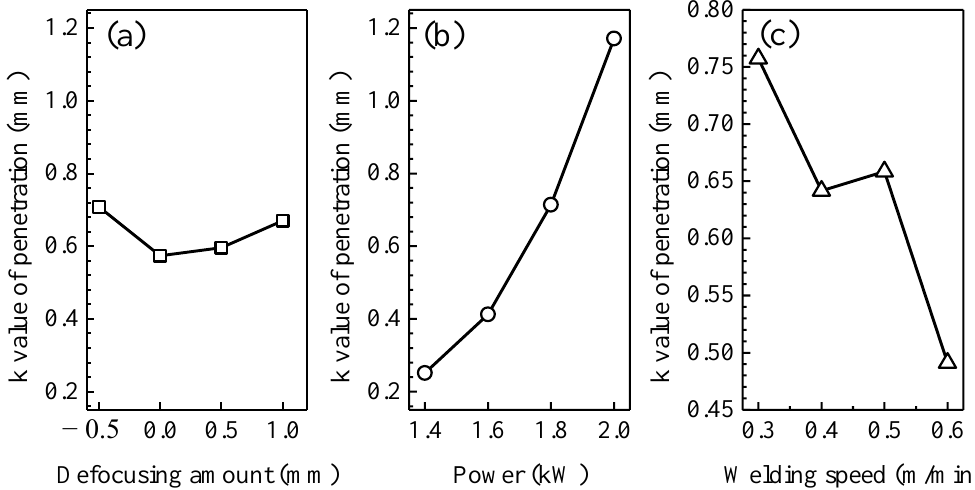
Figure 3. Relationships between ( a ) the defocusing amount, ( b ) power, and ( c ) welding speed with